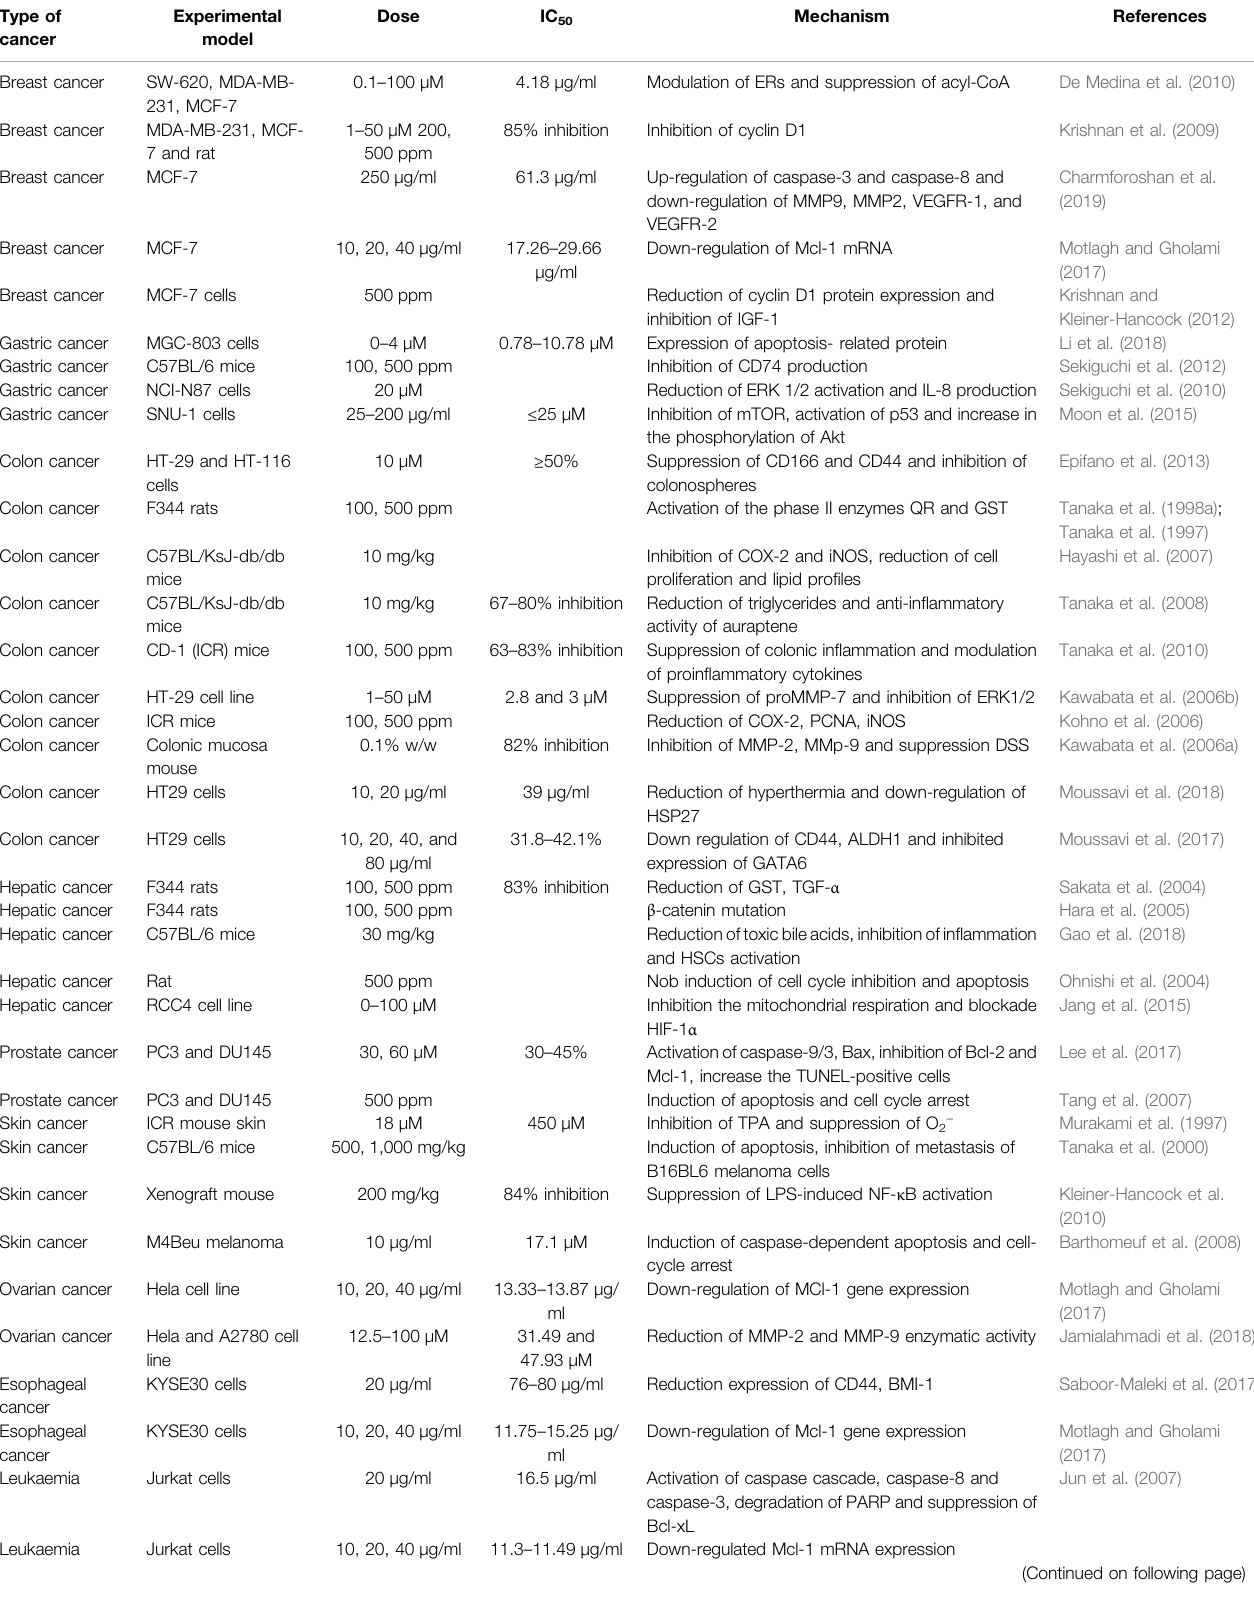
TABLE 1 | The antitumor experiment of auraptene in vitro and in vivo